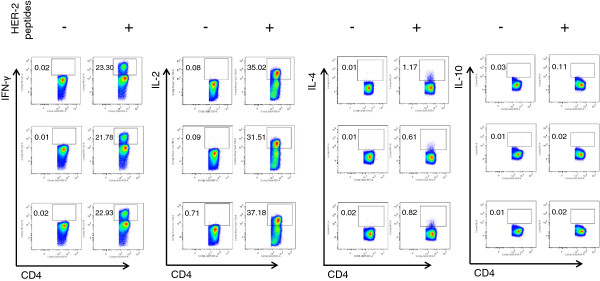
T cells stimulated with proTα- or proTα(100–109)-matured HER-2/neu-peptide-pulsed autologous DCs produce TH1-type cytokines. Monocytes from HLA-A2+/DR4+ donors were differentiated to iDCs, matured for 48 h with TNF-α, proTα or proTα(100–109), pulsed with HER-2(9369) and HER-2(15776) epitopes and used to stimulate autologous T cells. Recovered CD4+ T cells were analyzed for intracellular production of IFN-γ, IL-2, IL-4 and IL-10, in the absence (−) or presence (+) of the HER-2/neu peptides. First row, DCs matured with TNF-α; middle row, DCs matured with proTα; bottom row, DCs matured with proTα (100–109). Numbers indicate percentage of positive cells for each cytokine on gated CD4+ T cells. Shown data are from one representative donor of 5 tested.